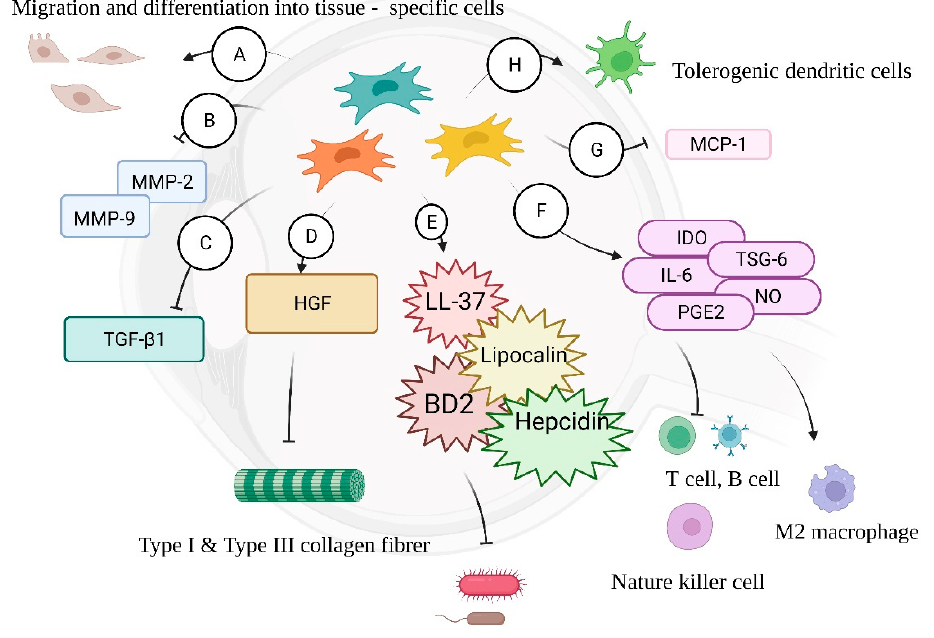
Figure 2. (A) MSCs can migrate to a site of inflammation and differentiate into tissue-specific cells for repair. (B) MSCs inhibit the expression of MMP-2 and MMP-9, attenuating scar formation. (C) Inhibition of TGF- β 1 signaling reduces fibrogenesis. (D) MSC-derived HGF reduces type I and type III collagen fibers, which contribute to scarring. (E) Antimicrobial molecules including